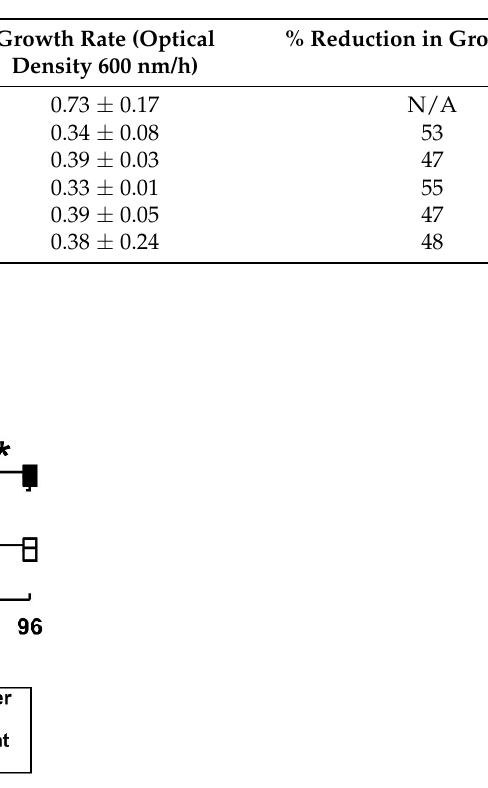
Figure 5. Virulence of untreated P. aeruginosa NCTC13437 compared with five persister colonies of the same strain that survived exposure to combination therapy in G. mellonella . Groups of G. mellonella larvae were infected with 2.5 × 10 2 cfu/mL of P. aeruginosa NCTC13437 not exposed to carbapenem therapy, or, identical numbers of 5 independent persister isolates of the same strain that were isolated from 5 G. mellonella larvae that had been infected and treated with the carbapenem combination MEM + DOR + ETP after 96 h. The experiment was carried out in duplicate and the survival curves for the larvae infected with the 5 combination-treated persister isolates were pooled and the mean ± SEM is shown. * Indicates significantly enhanced survival compared to larvae infected with P. aeruginosa NCTC13437 not exposed to carbapenem combination therapy ( p < 0.05, log rank test with Holm correction for multiple comparisons); n =